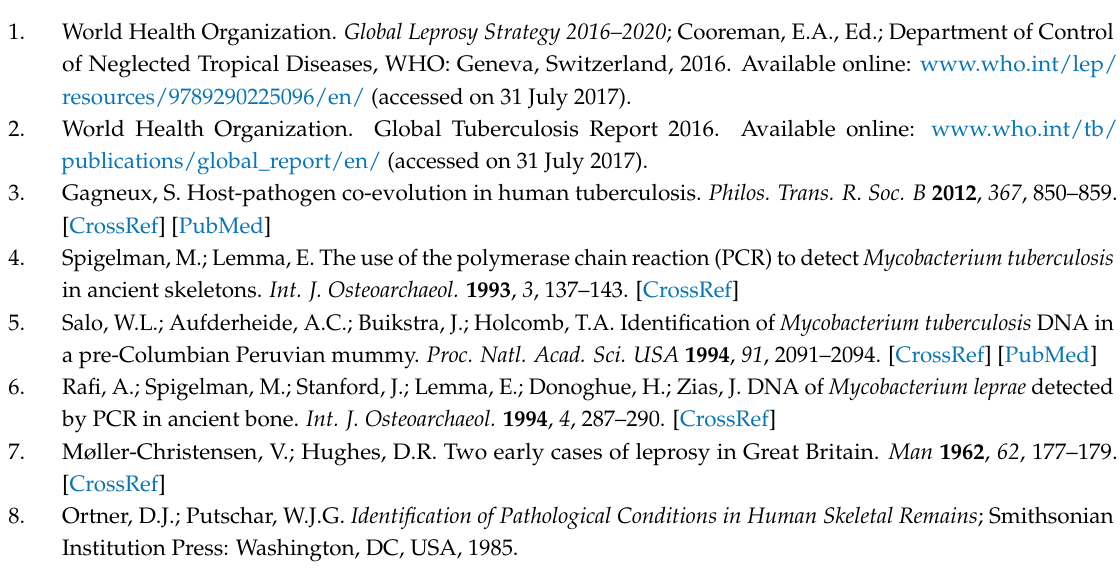
Table S1 : Summary of ancient tuberculosis methodology and biomarker findings according to date of publication. Table S2 : Summary of ancient leprosy methodology and biomarker findings according to date of